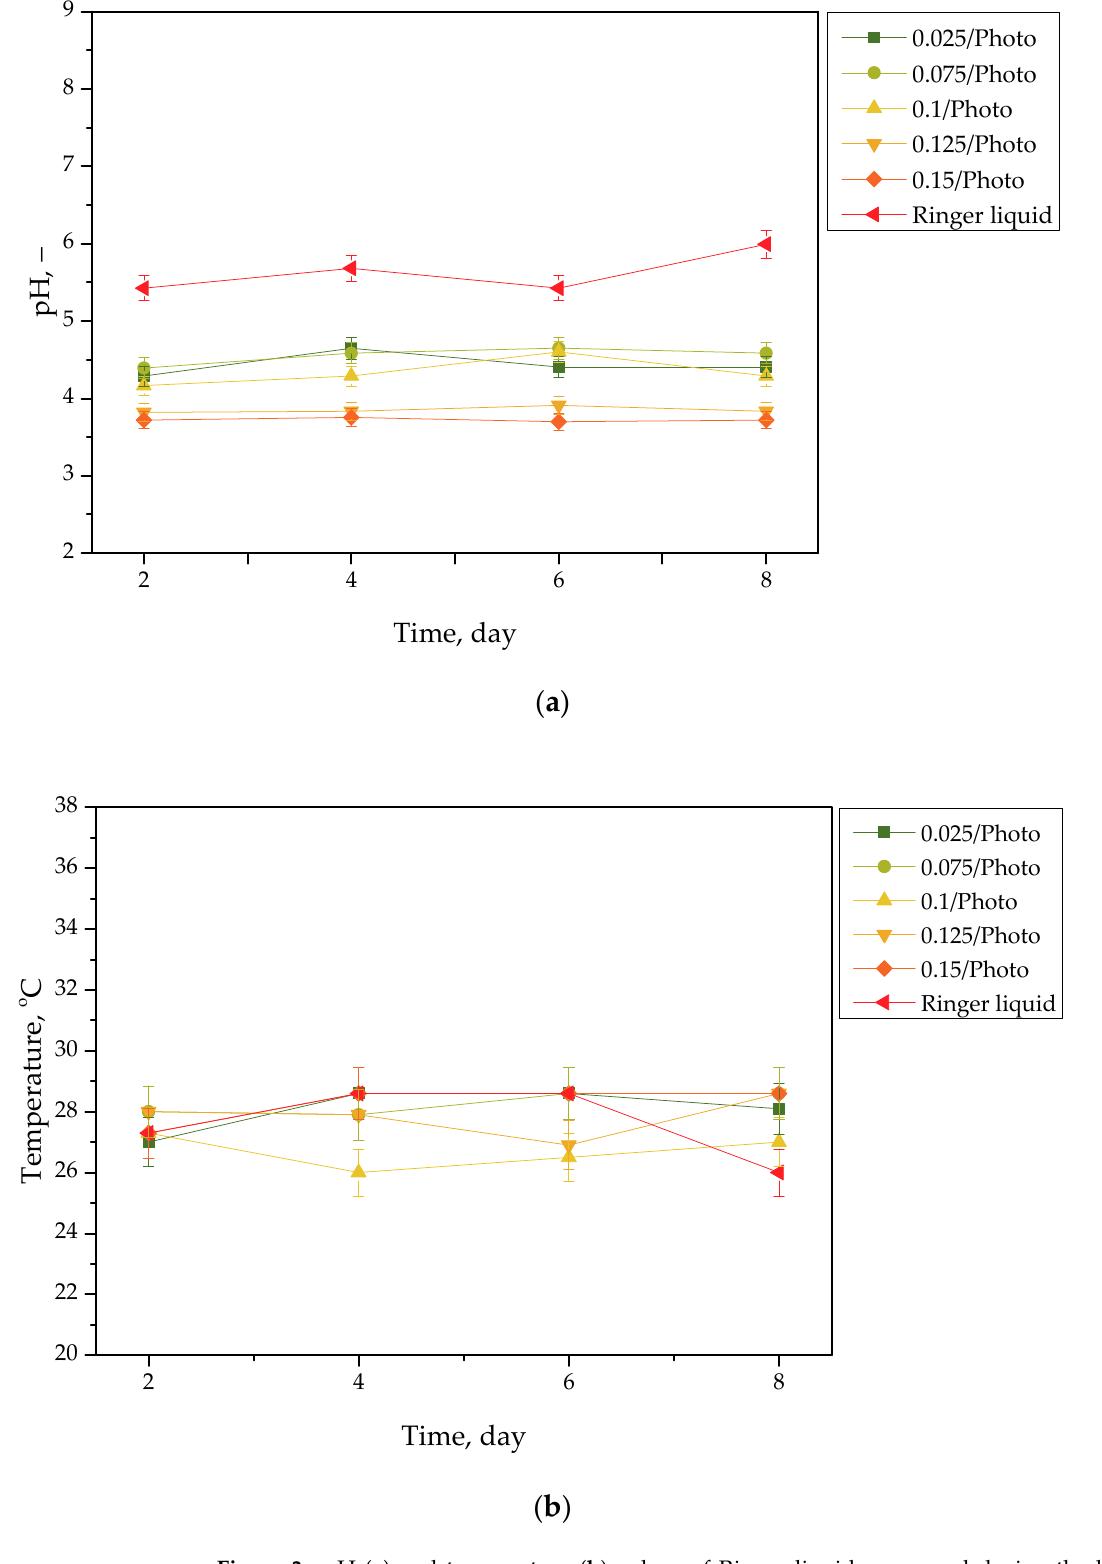
Figure 3. pH ( a ) and temperature ( b ) values of Ringer liquid, measured during the hydrogels’ incubation period (n = 3, n—number of repetitions).